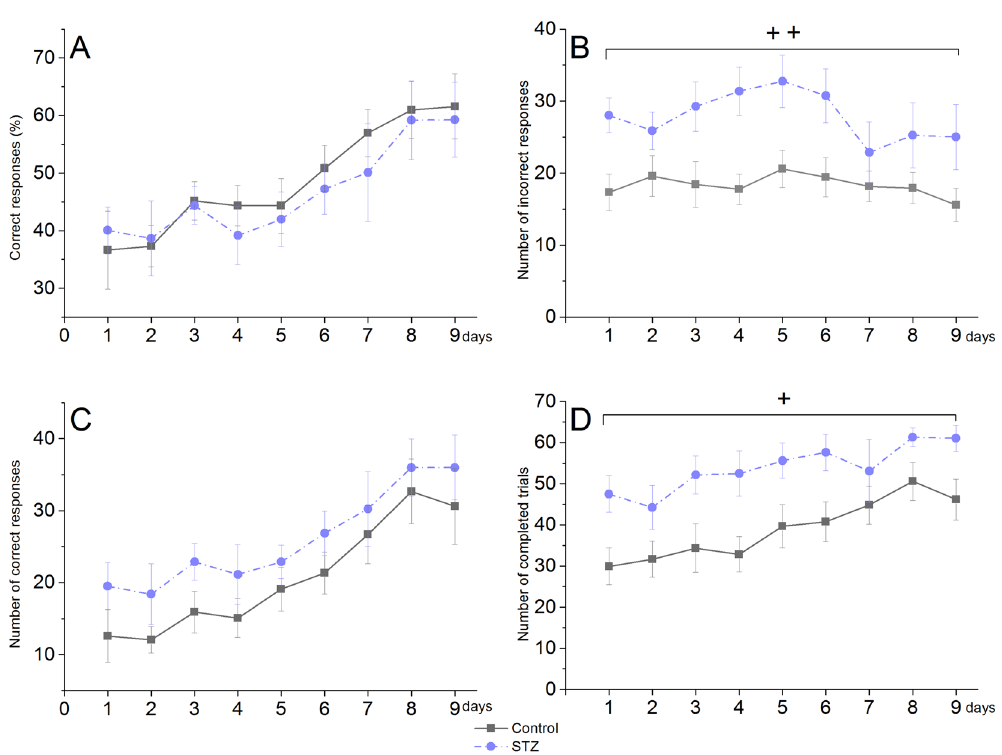
Figure 6. Pairwise visual discrimination performance of icv. STZ-injected (‘STZ’) and vehicle-treated (‘control’) old rats in a touchscreen apparatus in the post-injection period of Week 12–14. Means ± SEM values are shown. ( A ) Percentage of correct responses ( B ) Number of incorrect responses. + + : p = 0.005 significant treatment effect (F(1,18) = 10.28). ( C ) Number of correct responses. ( D ) Number of completed trials. + : p = 0.018 significant treatment effect (F(1,18) = 6.83). Group size of old STZ-treated rats: n =